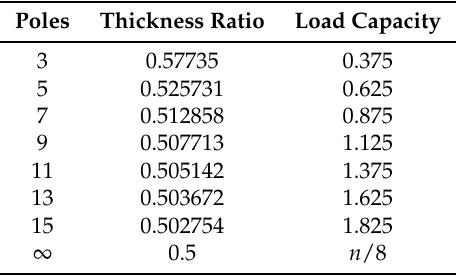
Table 1. Back iron thickness versus pole